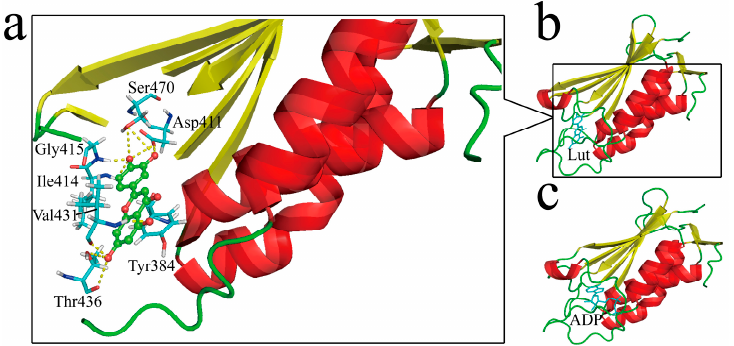
Figure 6. Structural insights of Lut binding to HK853 CA : ( a ) Interaction details of Lut with the surrounding residues of HK853 CA ; ( b ) simulative secondary structure of Lut binding to HK853 CA ; ( c ) crystal structure of ADP bound HK853 CA [15].